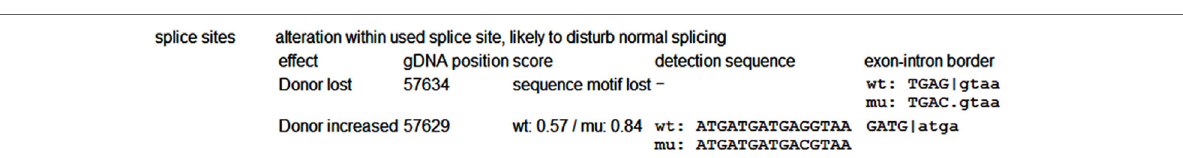
FIGURe 3 | Prediction of splice site changes using MutationTaster with the use of NNSplice database. As can be seen in this figure, due to the mutation in the position of 57634 in gDNA sequence, the lost of donor sequence motif has occurred and an increase for a donor site in position of 57629 has been predicted, and due to these changes, normal splicing may be disturbed. MutationTaster determines the position of splice site change relative to intron/exon borders: if a loss/ decrease of a splice site occurs at an intron/exon border or exon/intron border, this will be taken for a “real” splice site change. A gain of a completely new splice site is displayed, if the confidence score of the newly created splice site is > 0.3. An increase in an already existing splice site will be displayed if the change in the confidence score is > 10%. All changes are displayed with the effect, genomic position of the splice site, the prediction score for wild-type (wt) and/or mutated (mu) splice site as generated by NNSplice, the (wt) detection sequence itself and very short sequence information about the splice site, with a pipe (|) indicating the border between intron and